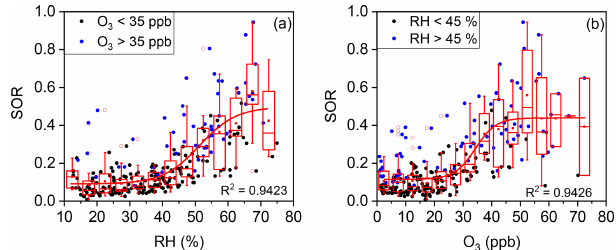
Figure 5. (a) Plot of the SOR against RH grouped by O 3 concen- tration. The solid blue circles represent O 3 > 35ppb and the solid black circles represent O 3 < 35ppb. (b) Plot of the SOR against O 3 grouped by RH. The solid blue circles represent RH > 45% and the solid black circles represent RH < 45%. The boxes represent, from top to bottom, the 75th, 50th, and 25th percentiles in each bin ( (cid:49) RH = 5%; (cid:49) O 3 = 5ppb). The whiskers, solid red squares, and open red circles represent 1.5 times the IQR, mean values, and outlier data points, respectively. The red lines are best fits to mean values based on a sigmoid function. Data for days with rain or snow were excluded from these